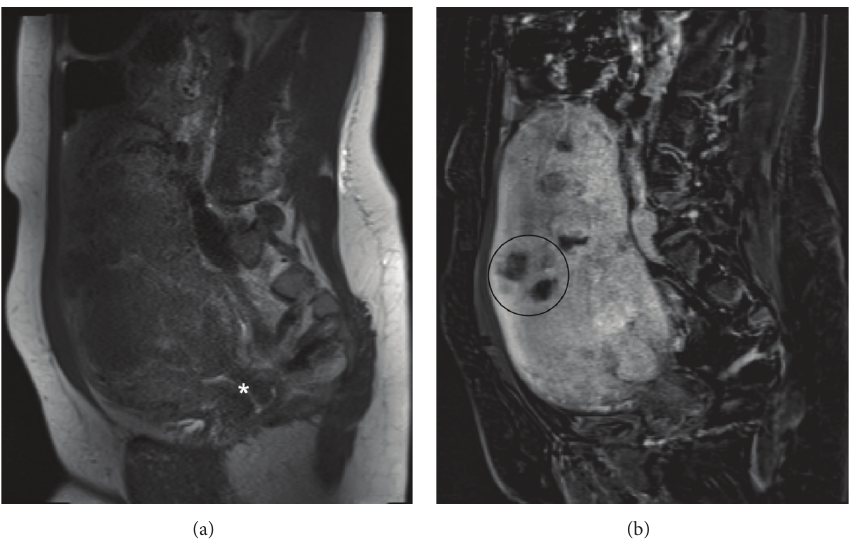
Figure 1: Sagittal view of pre-UFE pelvic MRI (a) prior to and (b) after gadolinium contrast injection. An enlarged uterus, at the level of the cervical canal (asterisk), contains numerous fibroids, with heterogeneous enhancement. One such midanterior mass is annotated (circle).